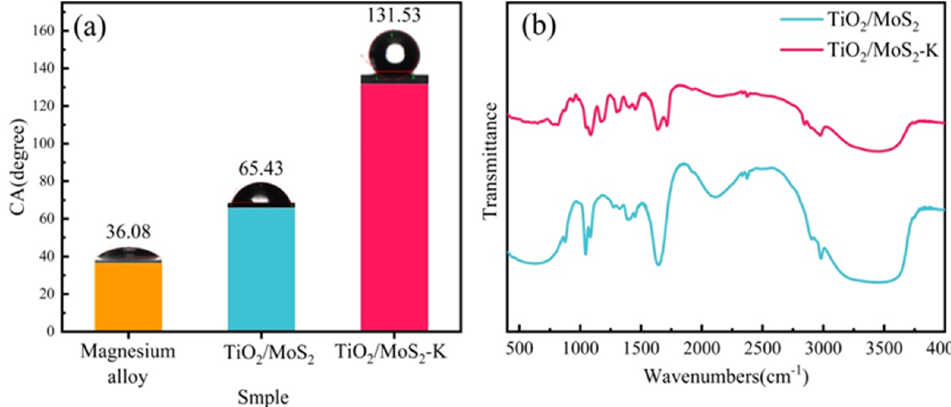
Figure 5. ( a ) Contact angles of magnesium alloy, TiO 2 /MoS 2 , and TiO 2 /MoS 2 -K; ( b ) FT-IR spectra of TiO 2 /MoS 2 and TiO 2 /MoS 2